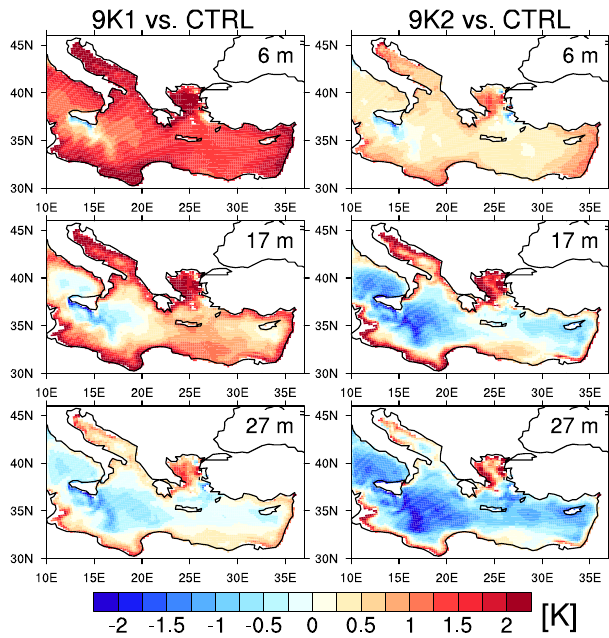
Fig. 11. Anomalies of summer (JAS) temperature at different depth levels, 9K1 vs. CTRL (left column) and 9K2 vs. CTRL (right column).